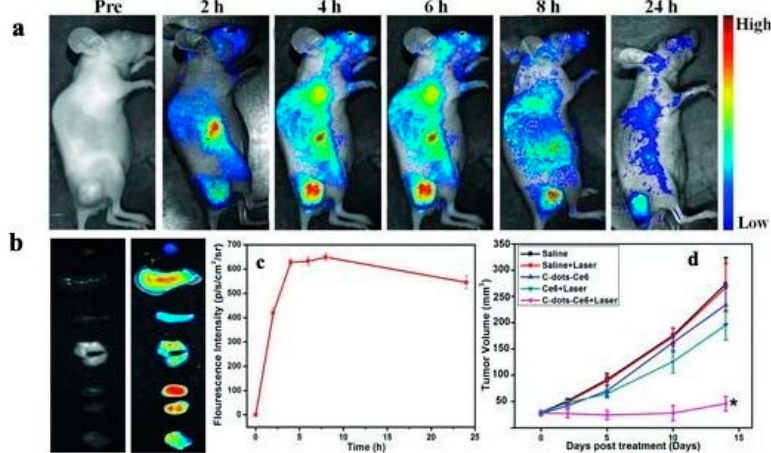
Figure 7. ( a ) Real-time in vivo NIR fluorescence images following intravenous injection of CDot-Ce6 into nude mice at different time points; ( b ) ex vivo tissue images (from top to bottom: heart, liver, spleen, lung, kidney, and tumor); ( c ) the fluorescence intensities in the tumor region during a 24-h period post-injection ( n = 5); ( d ) MGC803 tumor growth curves upon specified treatments ( n = 5). (* p < 0.05 for the C-dots-Ce6 + laser group vs. all other groups). Image adapted with permission from [144]. Beack et al. further conjugated CDot-Ce6 with hyaluronate (CDot-Ce6-HA) for easy transdermal PDT of melanoma skin cancers; because tumor tissues express more HA receptors, CDot-Ce6-HA could specifically target cancer cells and produce 1 O 2 when laser-irradiated. Singlet oxygen sensor